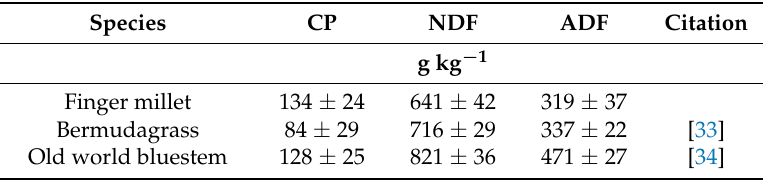
Table 4. Comparisons of forage nutritive value parameters of finger millet, bermudagrass, and old world